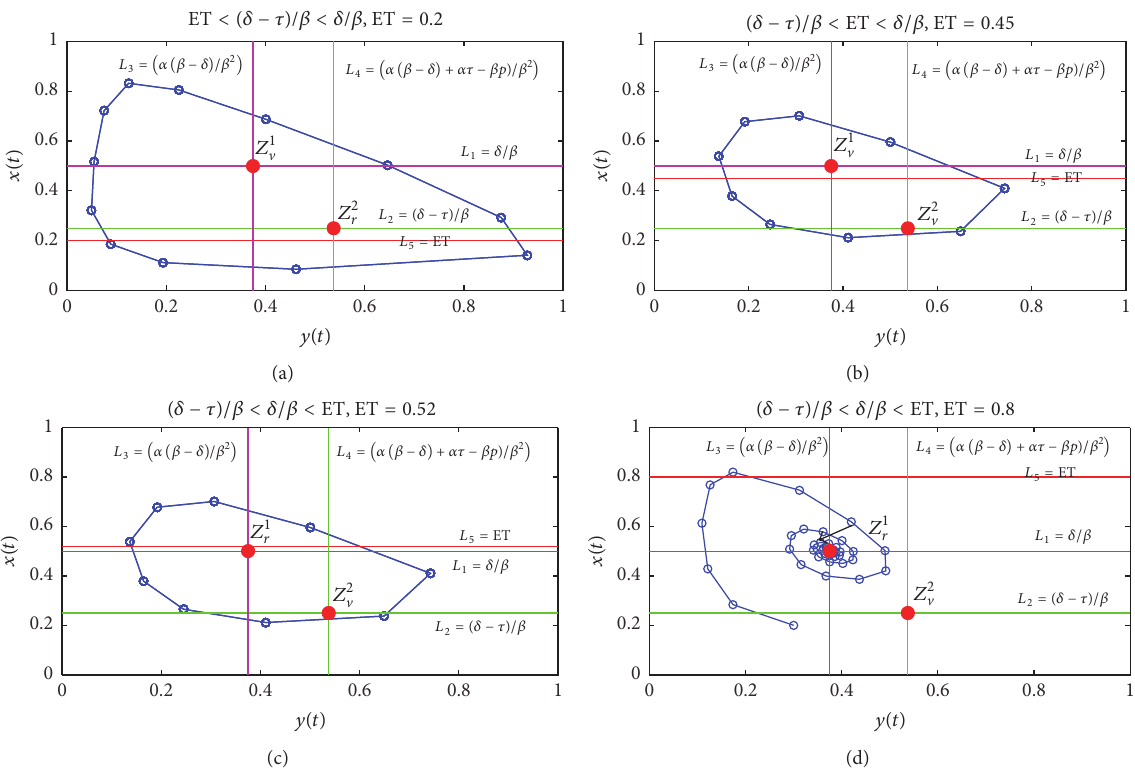
Figure 1: Real/virtual equilibria. The parameter values are fixed as follows: 𝑝 = 0.1, 𝜏 = 1, 𝜎 = 0.35, 𝛽 = 4, 𝛼 = 3 , and 𝛿 = 2.0 . (a) 𝑍 1 V and 𝑍 2 𝑟 coexist with ET